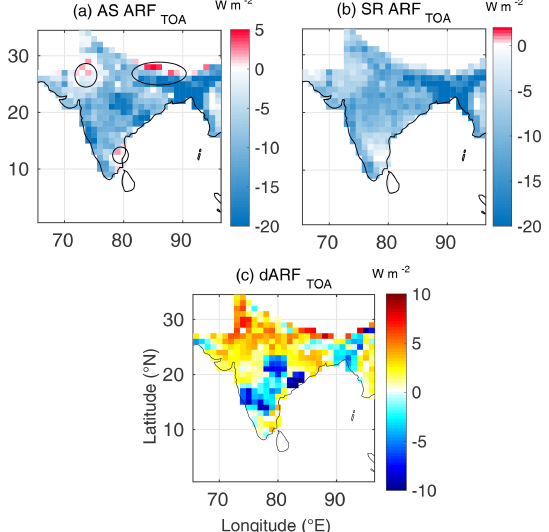
Figure 2. Spatial variation of (a) AS ARF TOA (radiative forcing estimated using AS AOD and AS SSA, at TOA), (b) SR ARF TOA (radiative forcing estimated using SR AOD and SR SSA, at TOA) and (c) dARF TOA for January 2009.